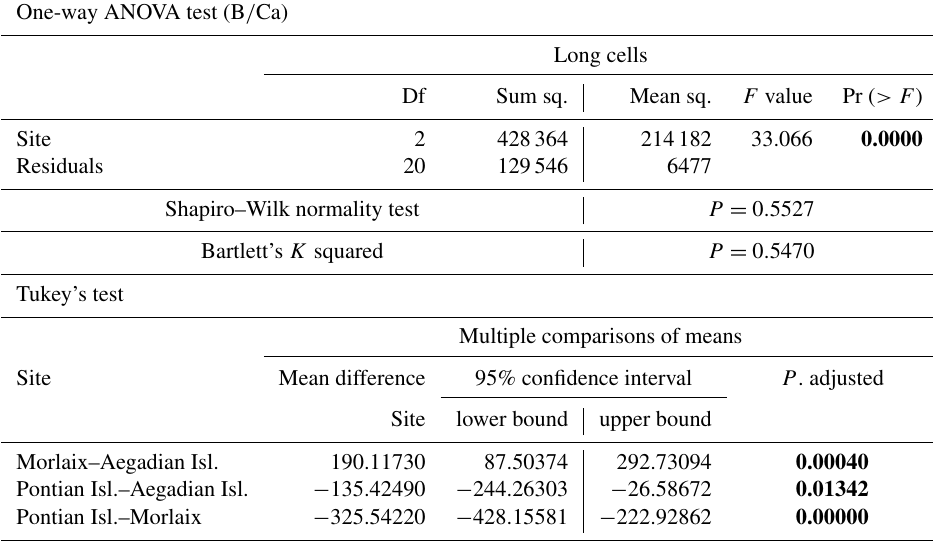
Table A4. Results of statistical tests performed to evaluate the differences of B / Ca in the long cells of L. corallioides collected at different sampling sites. Statistically significant p values are given in bold. ANOVA test significance at α = 0 . 05; Tukey’s test significant at p ≤ α .